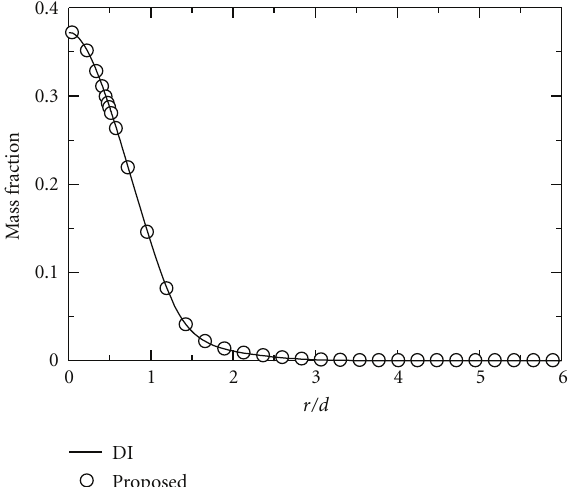
Figure 7: Radial mass fraction of CO at x/d = 10.